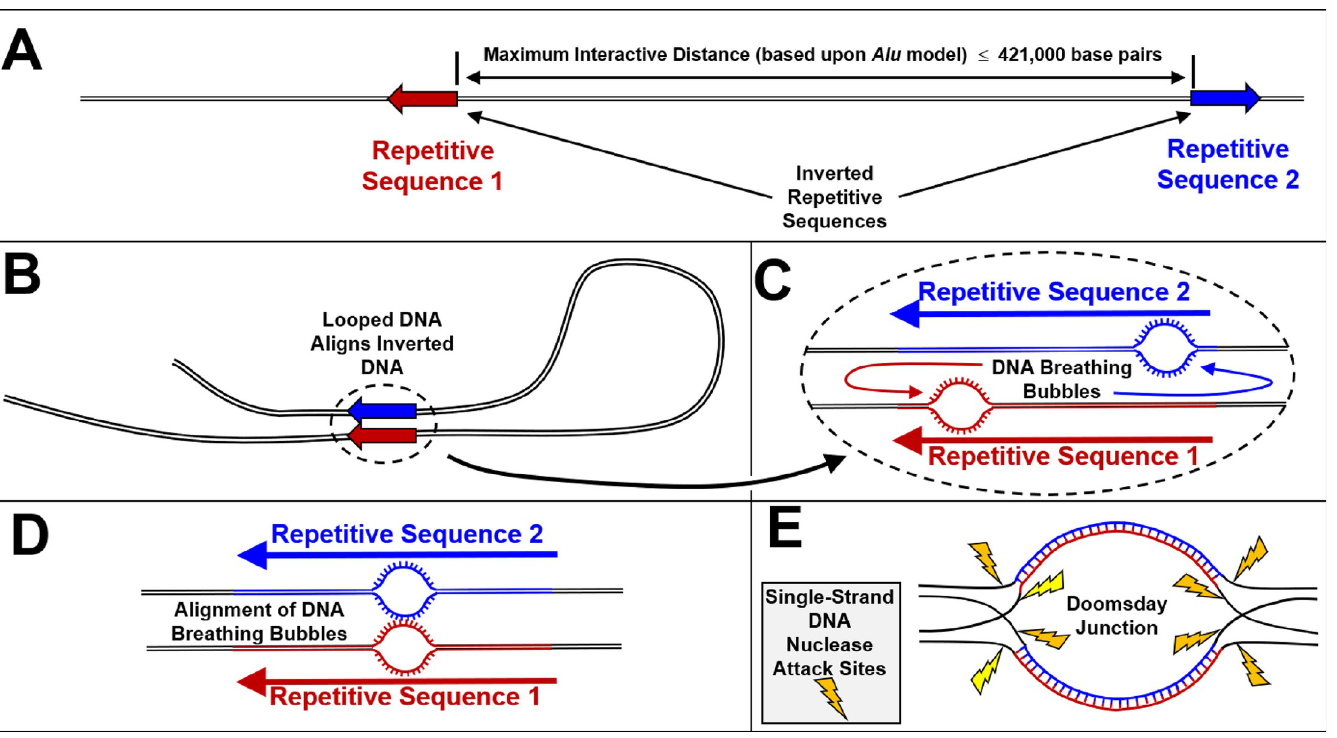
Fig 1. Proposed mechanism for the creation of double-strand DNA breaks resulting from the interaction of widely-spaced inverted repetitive sequences. A) Representation of an inverted repetitive sequence. Human inverted Alu element pairs are statistically depleted relative to direct-oriented Alu pairs up to a spacer size of 421,000 bp. B) DNA looping can create alignment of inverted pairs. C) Reactive single-stranded DNA is created both by DNA breathing bubbles as shown in this pane and also by replication forks. Note that the bases flip outward in breathing bubbles because of steric hindrance. This flipping out of bases makes the DNA more susceptible to interacting with a complementary breathing bubble. D) If single-stranded conformations of DNA occur in aligned inverted sequences, ectopic invasion and annealing can occur. E) Eight short stretches of DNA would be created as DNA makes the transition from its normal double-stranded form into a Doomsday Junction conformation. As with DNA hairpins, these short stretches of single-stranded DNA are susceptible to DNA nuclease attack (58). Random cleavage of the eight single-stranded DNA sites is hypothesized to continue until the Doomsday Junction is resolved. If both strands of the same DNA segment are cleaved, a double-strand break can be